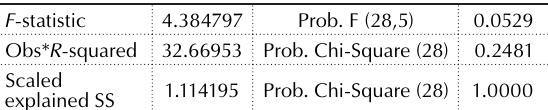
Table 18. Heteroskedasticity